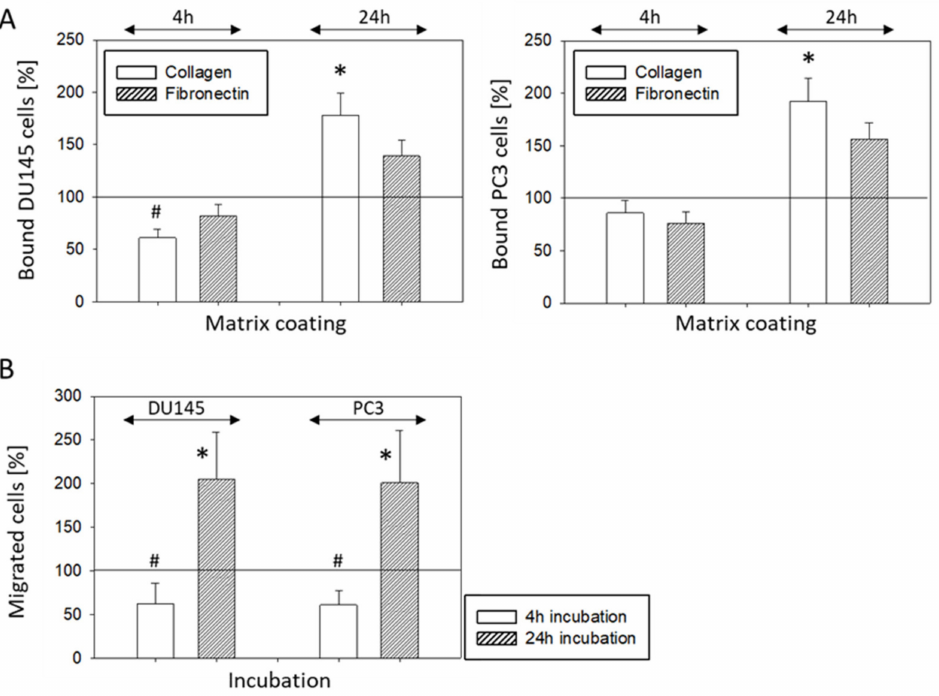
Figure 3. ( A ) Adhesion of DU145 and PC3 cells to immobilized collagen or fibronectin after stimu- lation with IGF-1 for 4 or 24 h. Mean number of adherent tumor cells from five fields. * indicates significant up-regulation to untreated control, # indicates significant down-regulation to untreated control ( n = 4). ( B ) Chemotactic movement of DU145 and PC3 cells after stimulation with IGF-1 for 4 or 24 h. Controls remained untreated. Mean number of tumor cells crawling beneath the filter membrane. * indicates significant up-regulation to untreated control, # indicates significant down-regulation to untreated control ( n = 3). All values are related to untreated controls set to 100%.